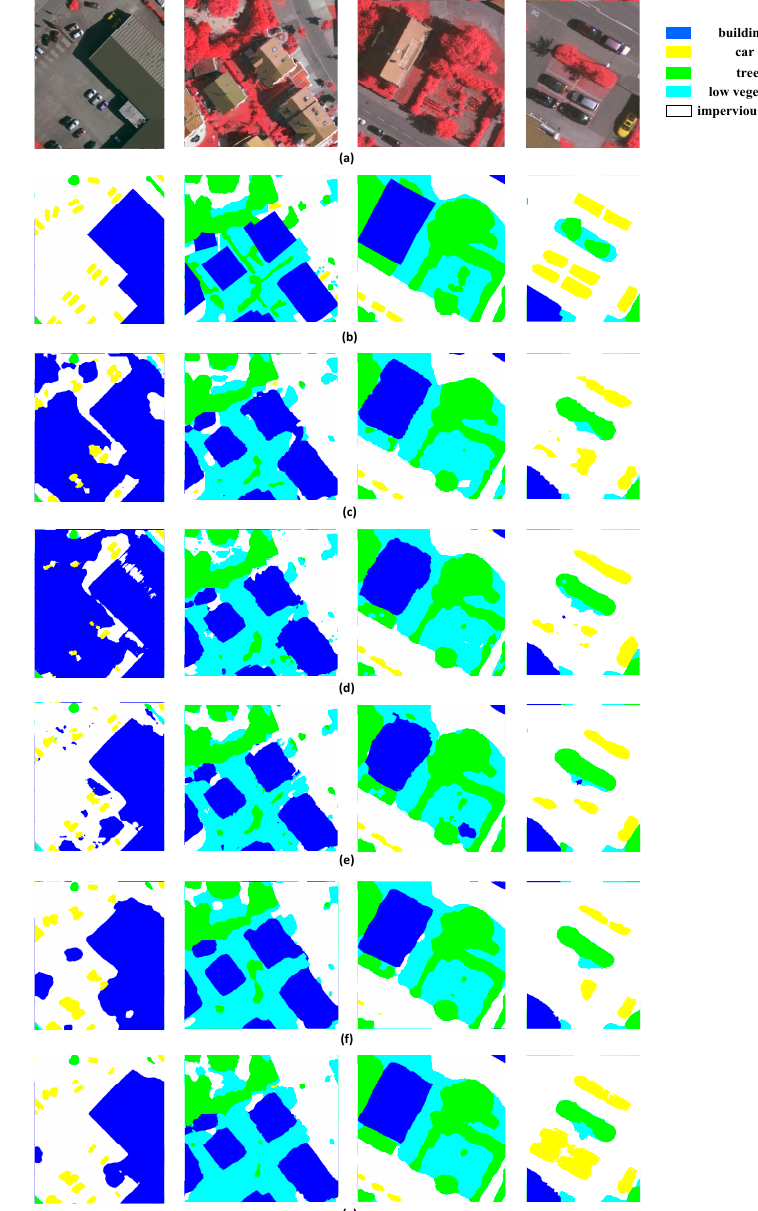
Figure 8. Classification results of the Vaihingen dataset. ( a ) Original images; ( b ) ground truth (GT) labels, corresponding to the images in ( a ); ( c ) Results of a basic fully convolutional network (FCN); ( d ) Results of FCN-8s; ( e ) Results of multi-layer perceptron (MLP); ( f ) Results of ASPP; ( g ) Results of our proposed